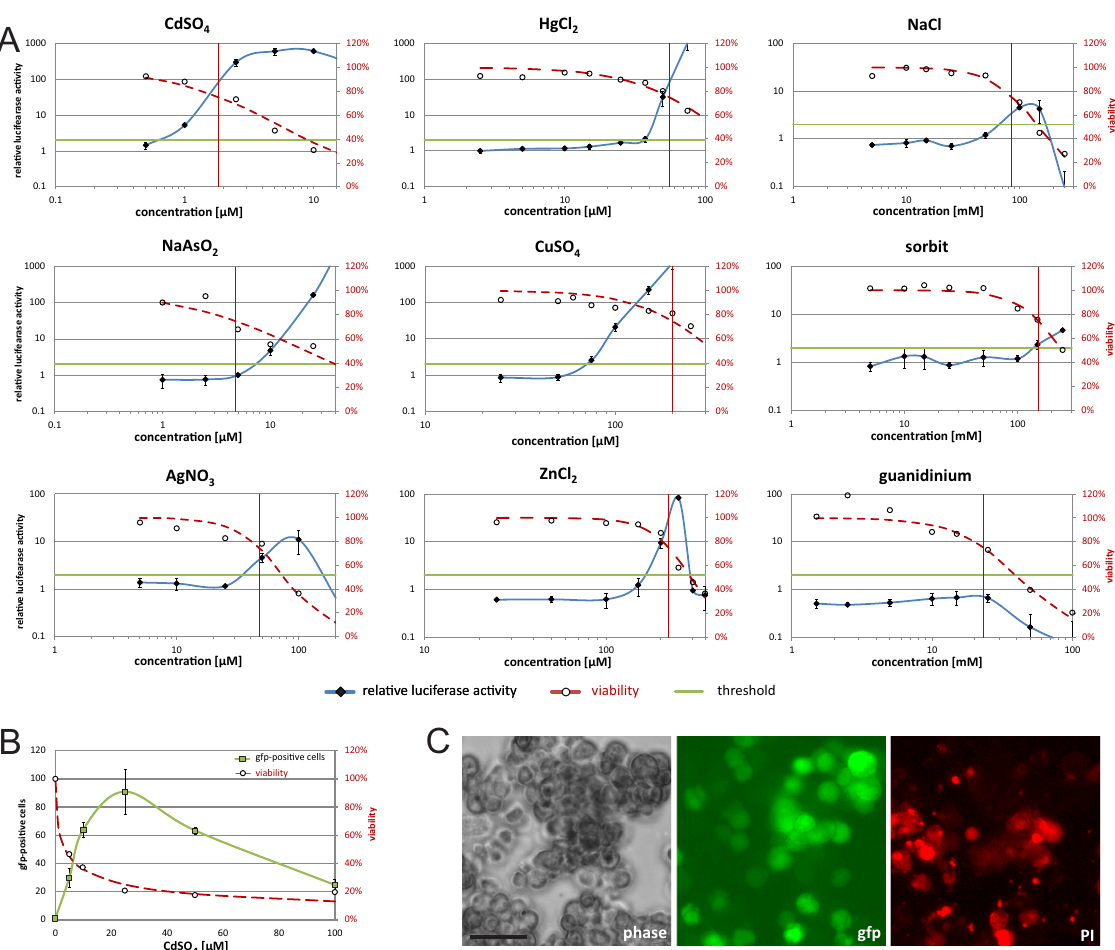
Fig 5. Detection of heavy metals with C5 cells. (A) C5 cells were incubated with different potential inducers for 24 h. All substances were diluted in complete medium. Viability (curve fitted, red dotted line, right y-axis) was measured with resazurin assay (A) or PI staining (B) and is shown relative to untreated cells. Red lines delimit regions above 75% viability. Left y-axis shows relative luciferase activity compared to untreated control cells. Green line (at relative luciferase activity of 2) indicates a threshold for significant induction. All values show means of at least three independent experiments with 12 technical replicates per plate. Error bars indicate SEM. (C) Pictures of C5 cells taken with fluorescence microscopy (scale bar 50 μ m) after treatment with 25 μ M CdSO 4 for 48 h. From left to right: phase contrast, GFP, PI staining. Under the same conditions as described in (A), percentage of GFP positive cells and dead cells (PI positive) was determined with flow cytometry (B).